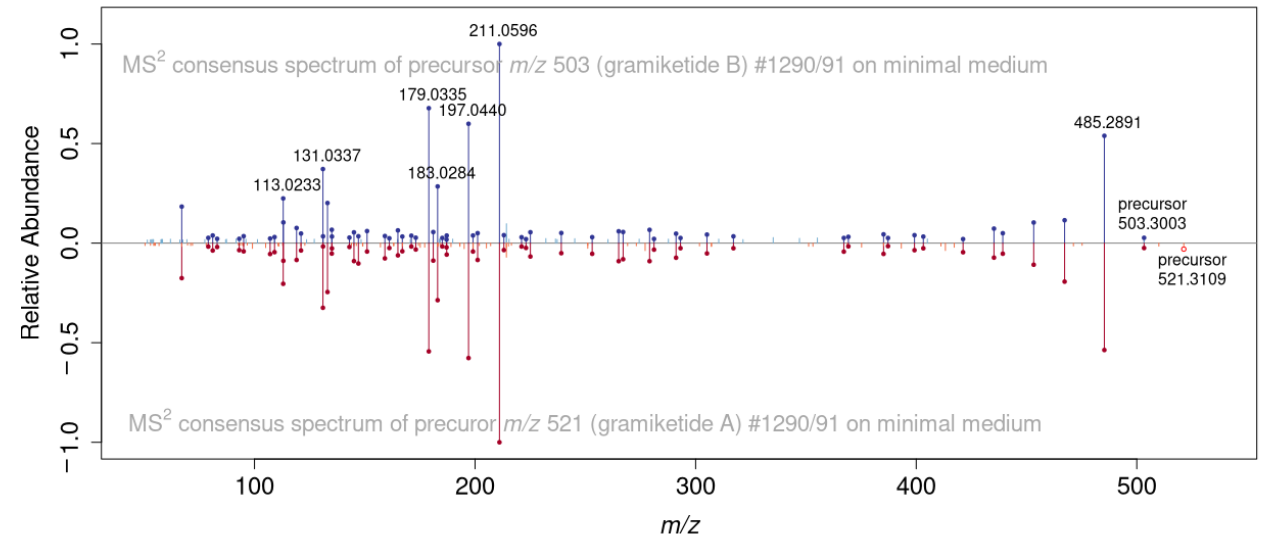
Figure 5. Comparison of MS/MS spectra of [M + H] + precursor ions of gramiketide A (red) and gramiketide B (blue), demonstrating the close structural similarity of the two metabolites. Matching fragments are marked with dots.